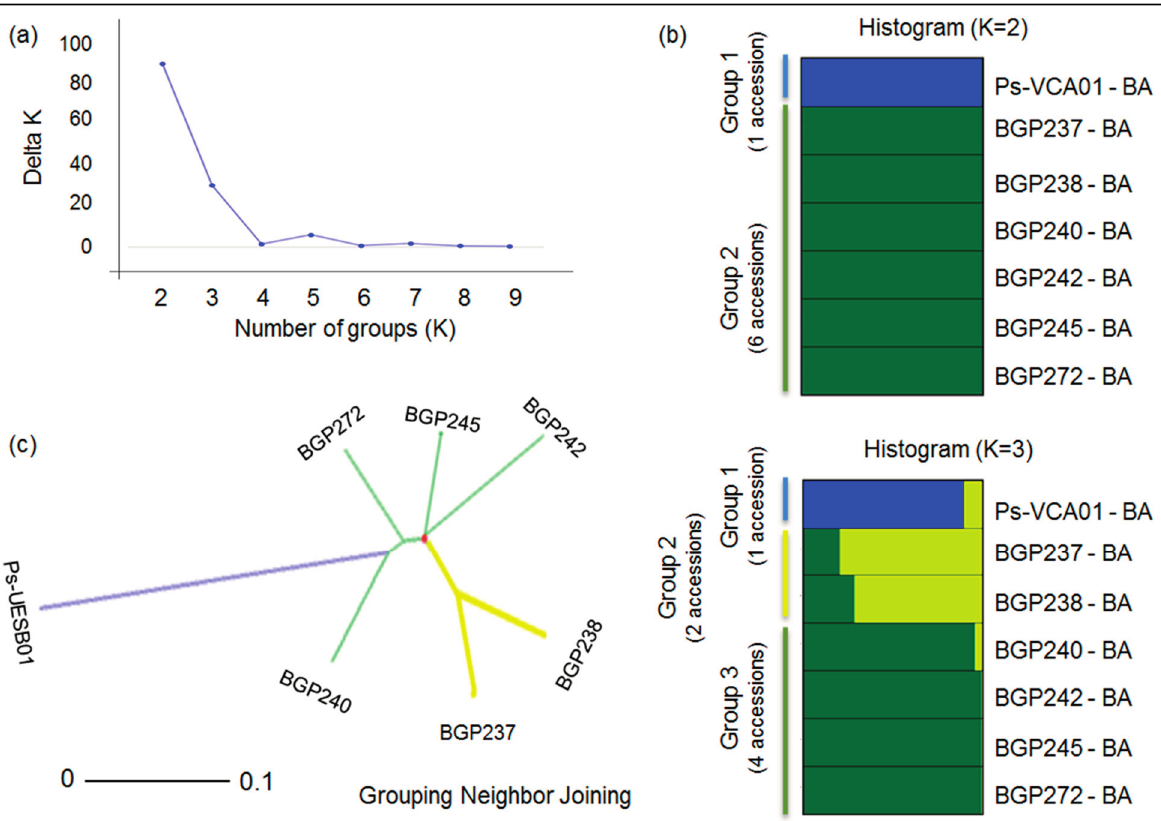
Figure 4. Intraspecific genetic structure of P. setacea . Clusters were inferred based on Bayesian analyses considering the most probable number of groups (K) estimated with the method described by Evanno et al. [43] ( a ); Each column (histogram) ( b ) and line (unrooted neighbor-joining tree) ( c ) represents the genotyping data from three to 12 plants. The tree was constructed using Rogers’ genetic distance, as modified by Wright [42], among seven passion fruit accessions. The colors used in the histogram and tree represent the most likely ancestry of the cluster from which the accessions were derived.